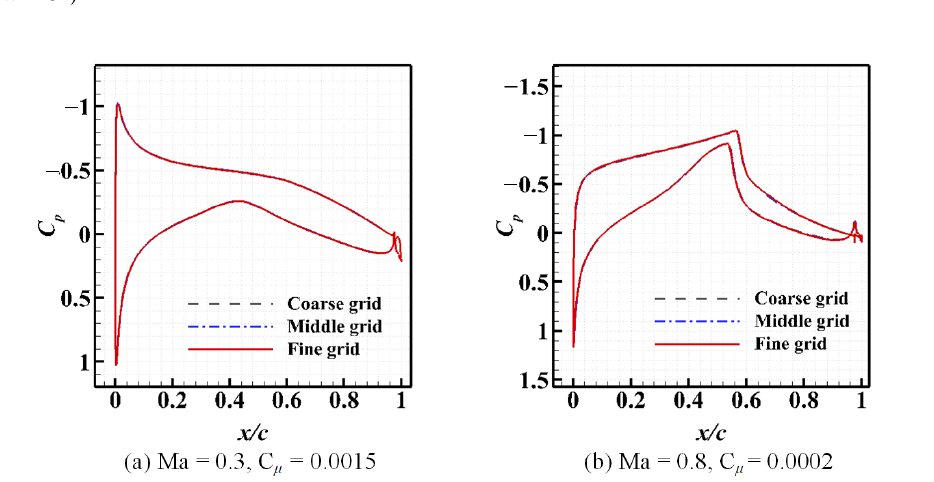
Figure 10. Influence of grid resolution for Ma = 0.3 and 0.8 at α = 3 ◦